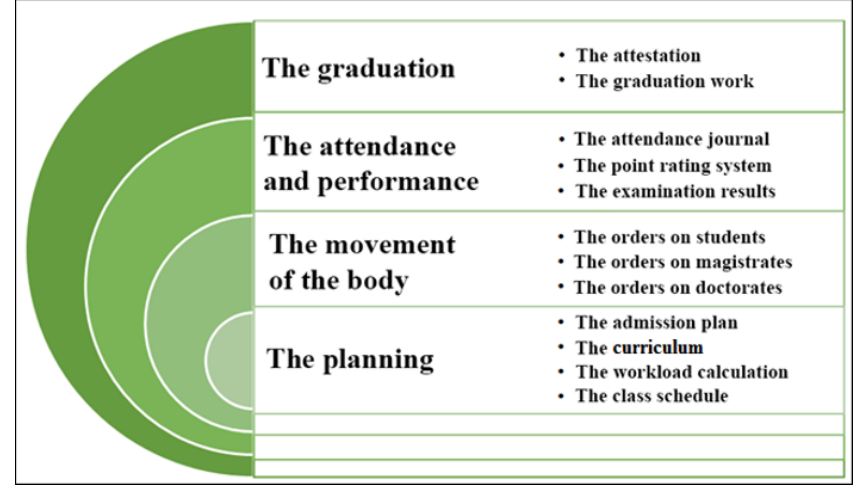
Fig. 6. Process approach to the document management of KPITTU